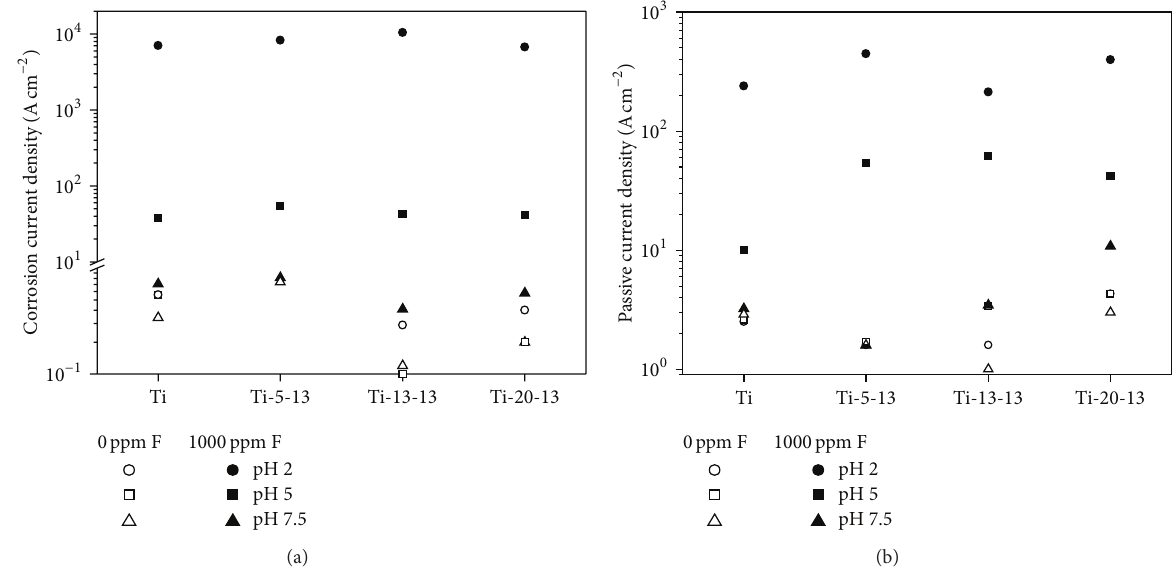
Figure 4: (a) Corrosion current densities and (b) passive current densities (measured at 1.0V/SCE) of CP-Ti, Ti-5Nb-13Zr, Ti-13Nb-13Zr, and Ti-20Nb-13Zr in Ringer’s solution of pH 2, 5, and 7.5 without fluoride and containing 1000 ppm F at 37 ∘ C.